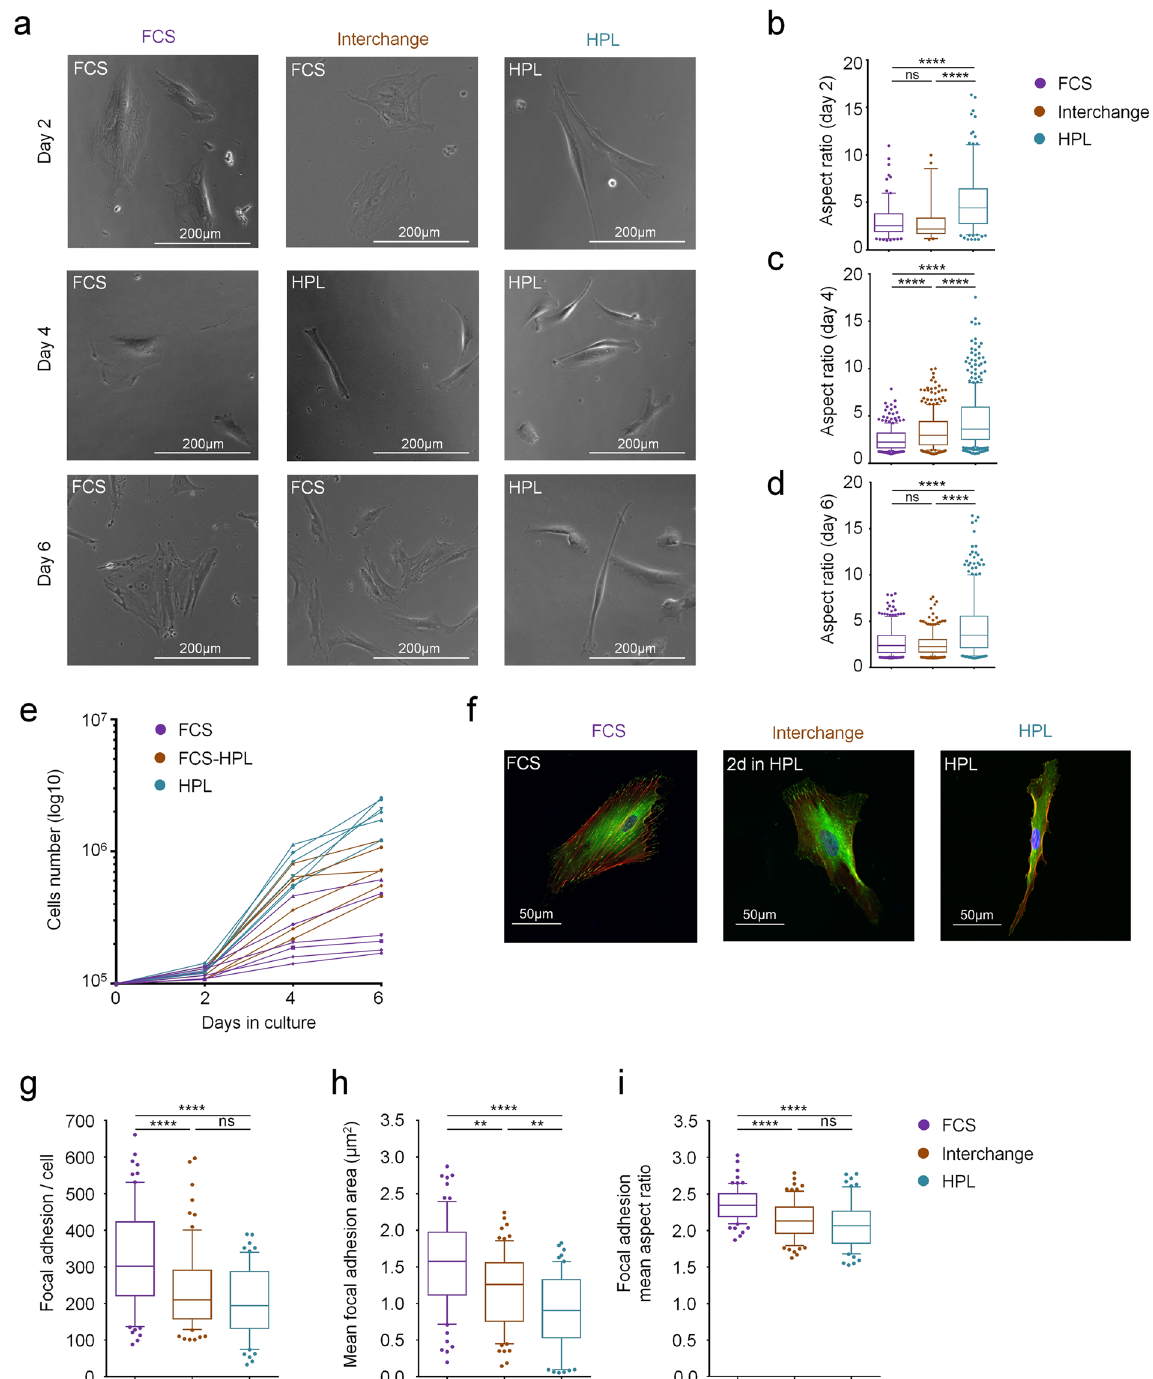
Figure 4. Growth of MSCs is reversible by interchanging the culture conditions. ( a ) To determine if effects of supplements are reversible, we have interchanged culture media from FCS (2 days) to HPL (2 days) and then back to FCS (2 days) (n = 4). Exemplary phase contrast images are provided. ( b ) Aspect ratios at day 2 demonstrate that HPL-MSCs are more elongated than FCS-MSCs ( **** p < 0.0001). ( c ) Aspect ratios at day 4 demonstrate that interchanging to HPL-medium for only two days already results in significant elongation of the cells ( **** p < 0.0001). ( d ) This change in morphology is again reversible by again changing for two days to FCS culture medium (day 6; **** p < 0.0001). ( e ) Proliferation can be transiently accelerated by interchanging to HPL culture medium. ( f ) Immunofluorescence analysis of the actin cytoskeleton (green) and the focal- adhesion associated protein vinculin (red). Representative images at day 4 (2 days interchange to HPL medium; nucleus counterstained with DAPI in blue). ( g ) The number of focal adhesions, ( h ) mean area of focal adhesions per cell, and ( i ) mean aspect ratio of the focal adhesions were quantified at day 4. FCS-MSCs have more elongated focal adhesions than HPL-MSCs, and this is reversible by interchanging culture media for two days ( ** p < 0.01; **** p < 0.0001; ns = not